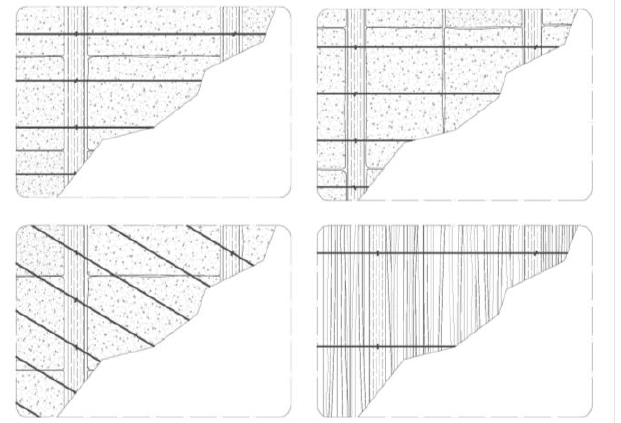
Figure 5. Squemes showing variations in tabique and quincha infills. a. ‘Tabique’ with single horizontal adobe and horizontal wiring b. ‘Tabique’ with double vertical adobes and horizontal wiring c. ‘Tabique’ with single horizontal adobe and diagonal wiring d. ‘Quincha’ with vertical tobacco branches confined with horizontal